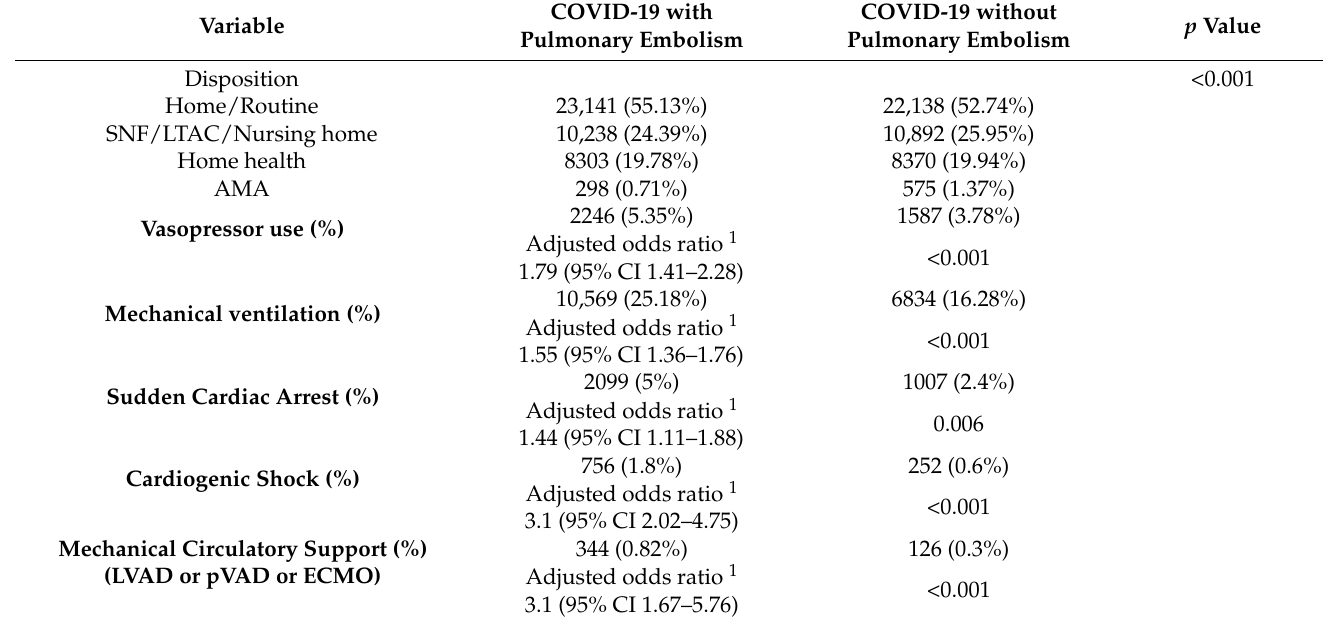
Table 5. In-hospital outcomes of Patients with COVID-19 with and without pulmonary